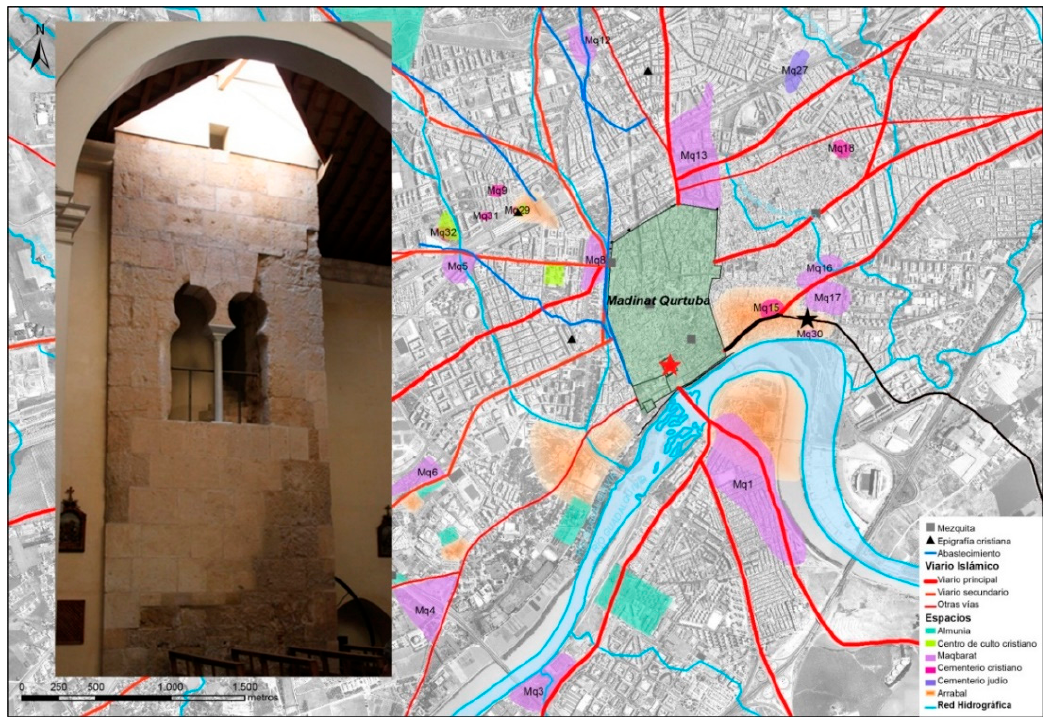
Figure 5. Location of the mosque currently visible in the church of Santiago (black star) in relation to the historical road (in black) and the Friday mosque (red star) (Created by author over the plan by Vaquerizo and Murillo 2010, p. 529, fig. 249. Used by their permission).